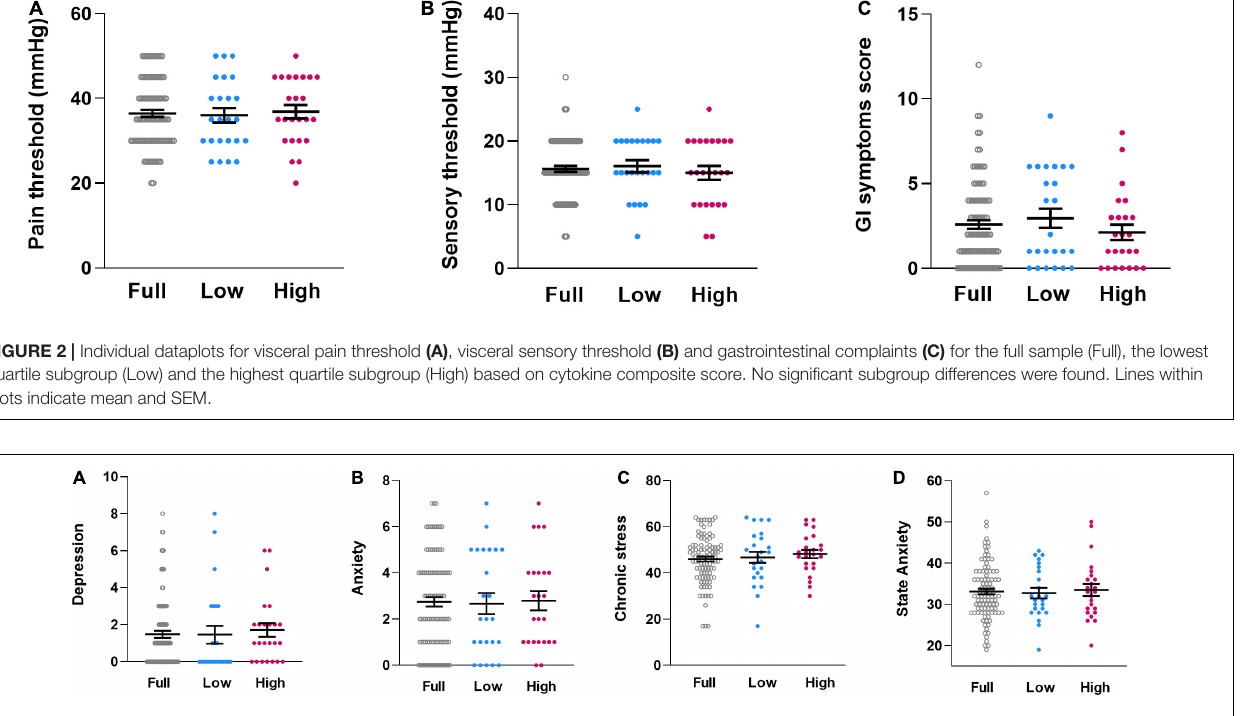
FIGURE 3 | Individual dataplots for symptoms of depression (A) , symptoms of anxiety (B) , chronic stress (C) , and state anxiety (D) , assessed with validated questionnaires, for the full sample (Full), the lowest quartile subgroup (Low) and the highest quartile subgroup (High) based on cytokine composite score. No significant subgroup differences were found. Lines within plots indicate mean and